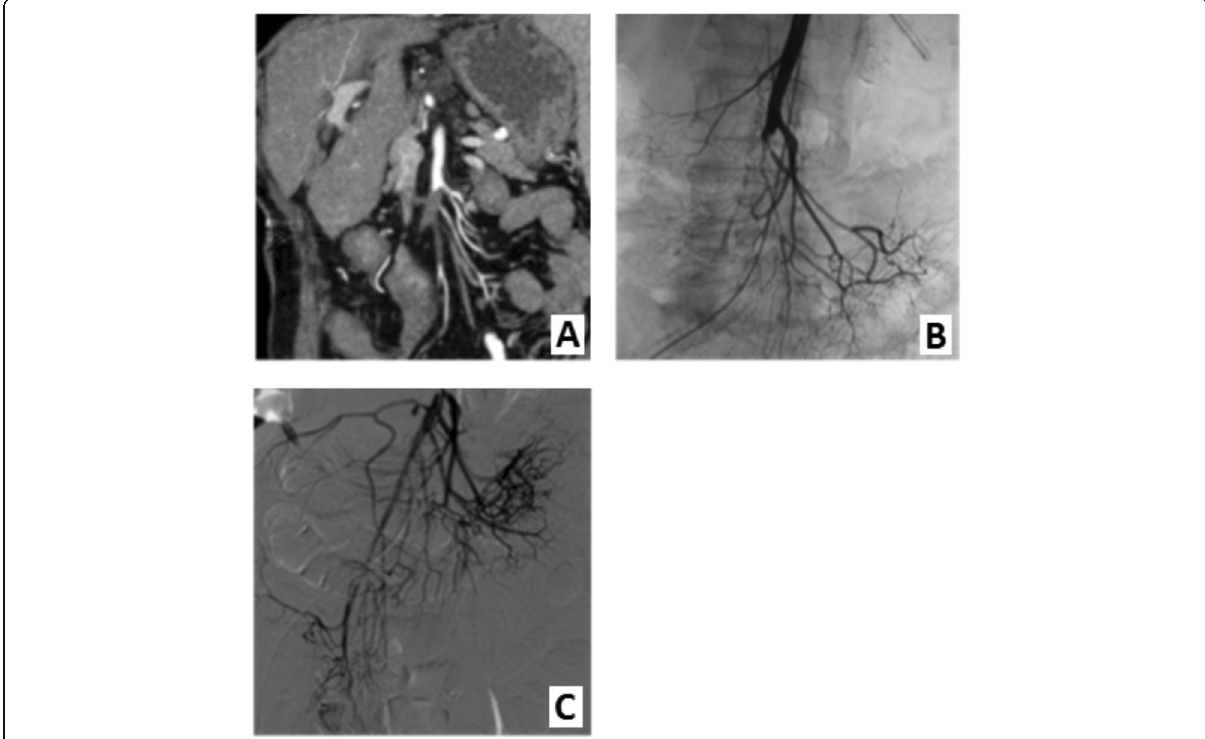
Fig. 2 SMA embolism in proximal side branches. a CT image, coronal view, arterial phase. b An-giography showing disrupted blood supply particularly to the ileocolic artery and branches. c Restored blood supply in affected segments after thrombosuction, thrombolysis and